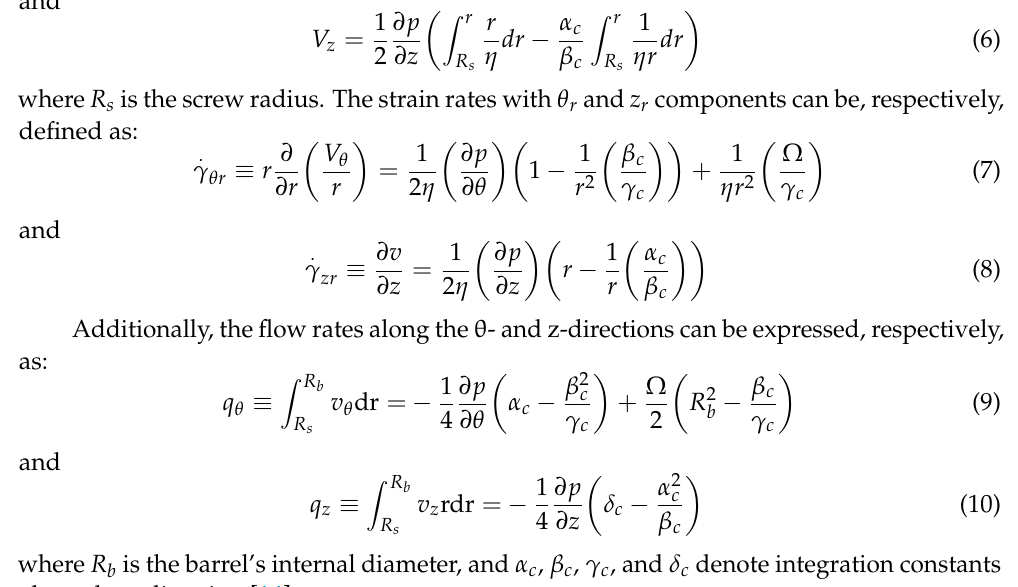
Figure 3. Schematic of the Hele – Shaw flow